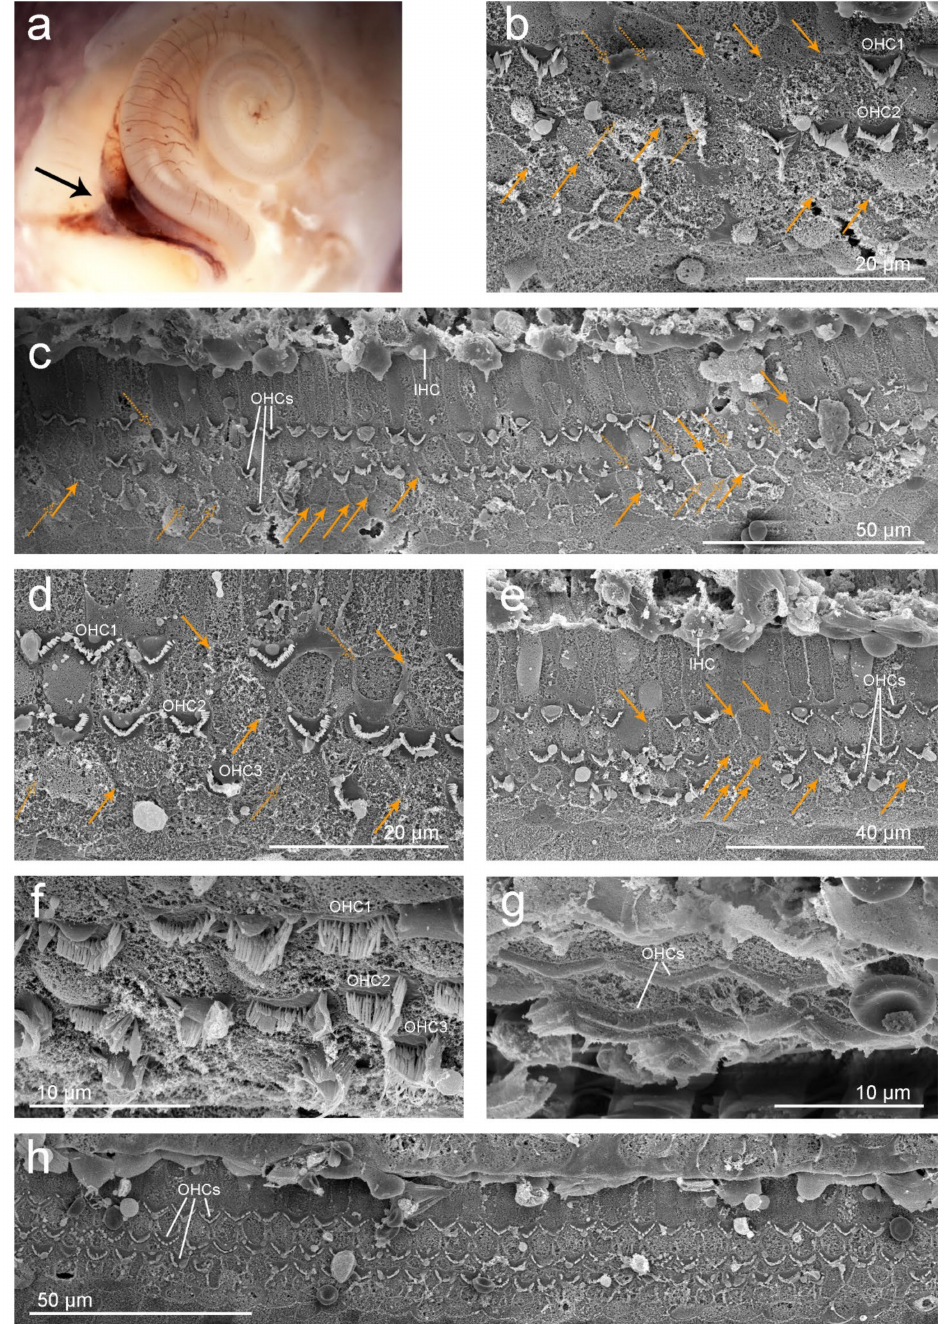
Figure 4. ( a ) Subgross image of the left cochlea from individual UT 1535. The black arrow highlights focal to segmental congestion involving the vein at the cochlear aqueduct. ( b – h ) Scanning electron microscope images. ( b – e ) Evidence of outer hair cell (OHC) death at the upper apical turn, highlighted with orange arrows. The dashed orange arrows indicate potential evidence of lesions. Panel ( c ) is located ~525 µ m from the beginning of the apex. The micrograph in panel ( b ) is taken 15 µ m after that of panel ( c ), towards the base. Panels ( d ) and ( e ) are located ~1.5 mm from the beginning of the apex. Organ of Corti with three rows of OHCs and one row of inner hair cells (IHCs) of the upper apical turn ( f ), upper ( h ) and lower ( g ) basal